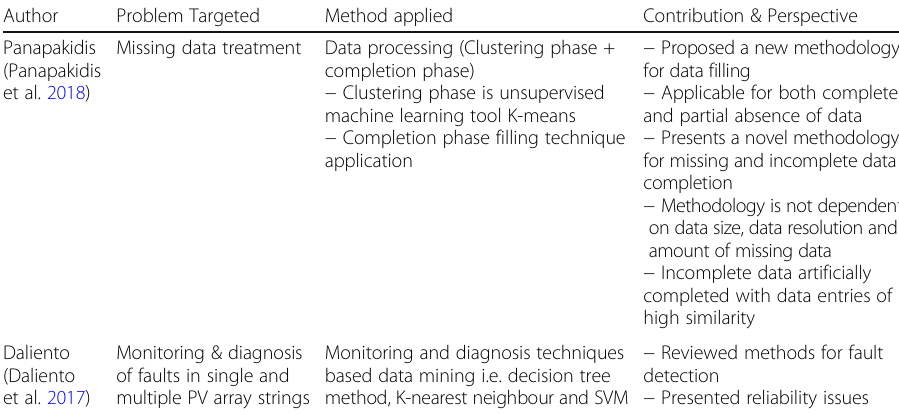
Table 1 State-of-the-art: Anomaly detection or outlier rejection